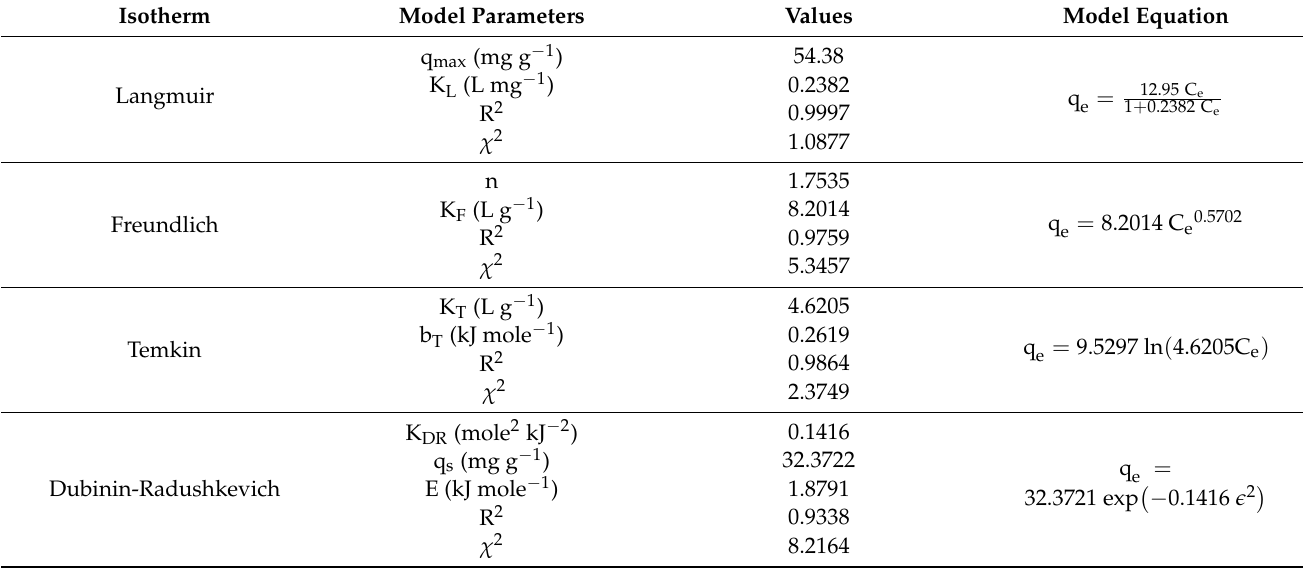
Table 7. Adsorption isotherm model parameters for RBBR dye adsorption onto WSBAC adsorbent. Isotherm